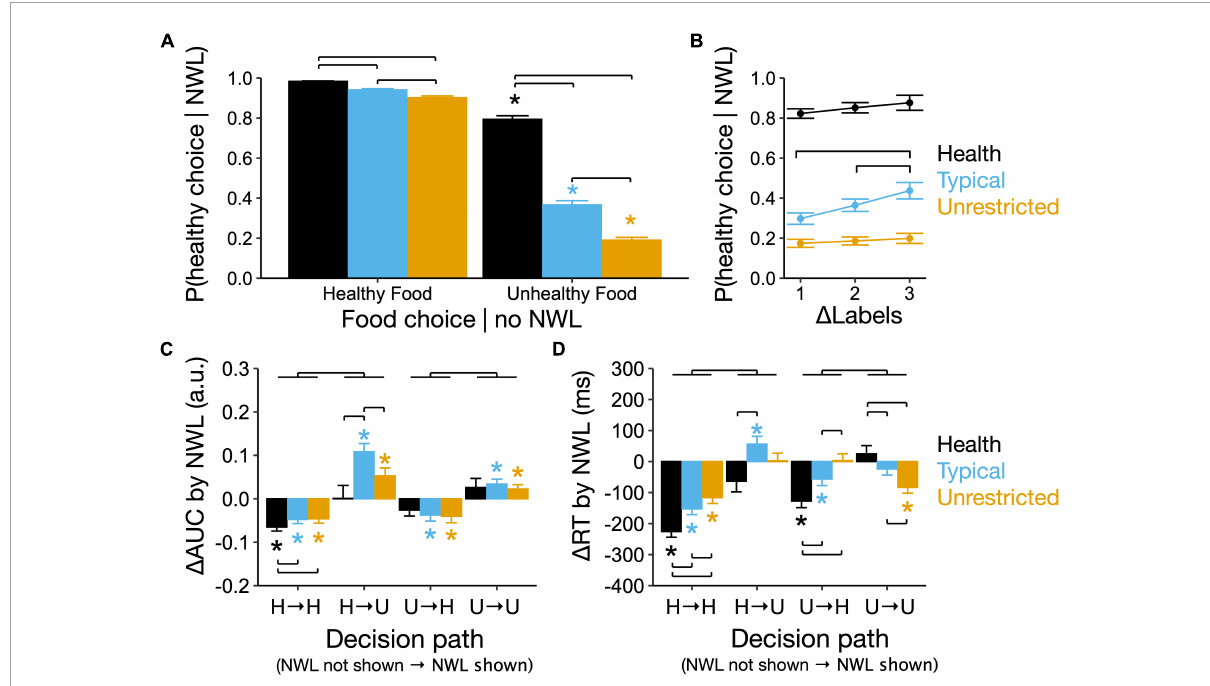
FIGURE4 Eating contexts determine the effect of showing nutrient warning labels (NWL) on conflict during decision and outcome of food choice. (A) Probability of a healthy food choice when showing NWL based on the prior choice made in the absence of NWL. Brackets, P < 0.05 pairwise differences between contexts within healthy and unhealthy choices. Stars, P < 0.05 between healthy and unhealthy choices within contexts. (B) Effect of increased absolute difference in the number of NWL between foods on the probability of healthy food choices in different contexts. Brackets, P < 0.05 pairwise differences between the number of food labels within context. (C) Change in area under the curve (AUC) ( (cid:49) AUC) and (D) change in reaction time (RT) ( (cid:49) AUC) between choices made with and without showing NWL. Brackets, P < 0.05 pairwise differences between contexts for each decision path (H, Healthy food choice; U, Unhealthy food choice). Asterisks, P < 0.05 for (cid:49) AUC or (cid:49) RT being different from zero. Upper brackets, P < 0.05 for differences between decision paths averaged over contexts.